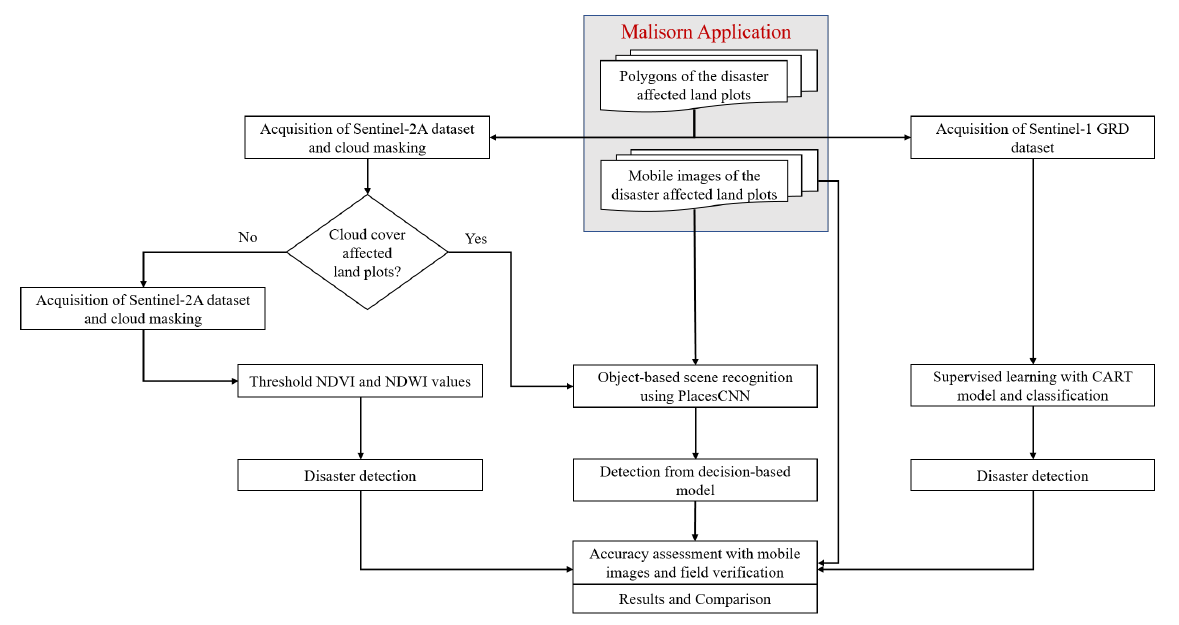
Figure 2. Workflow of our proposed method for flood and drought